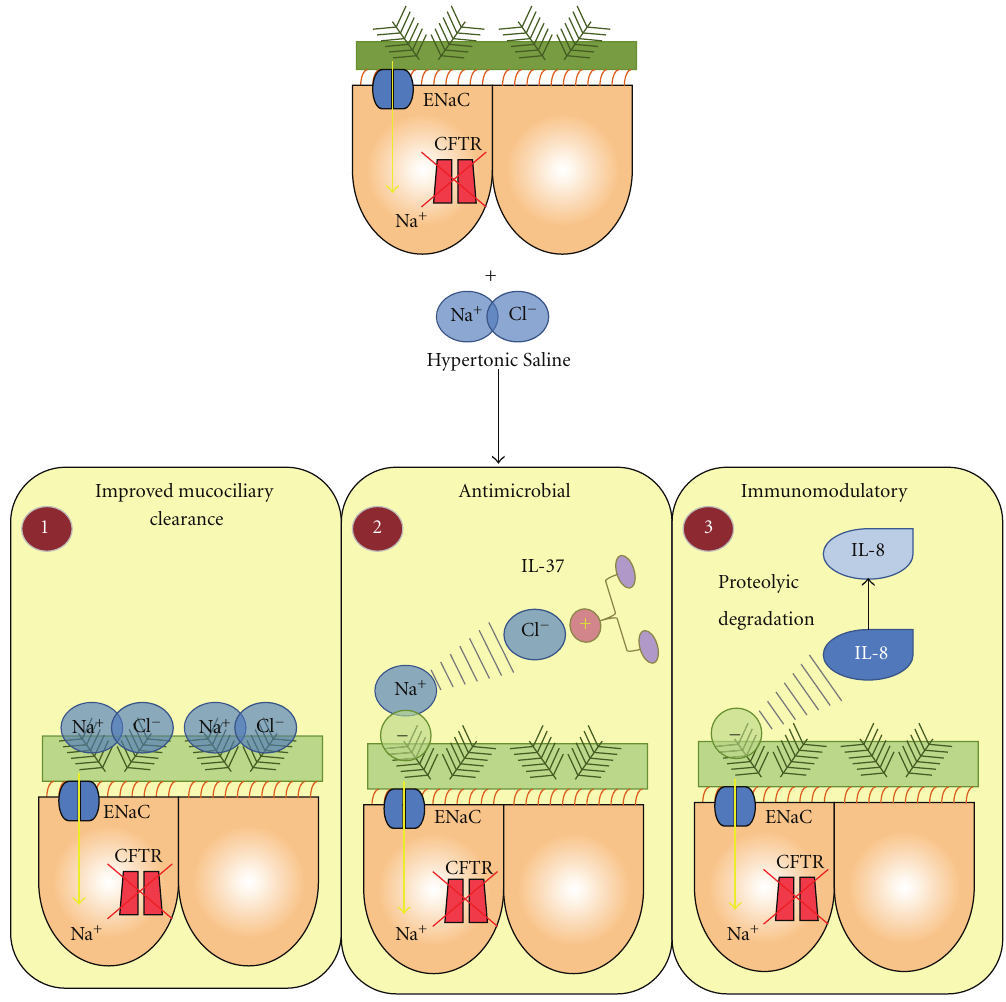
Figure 4: Schematic representation of the antimicrobial, immunomodulatory and mucolytic properties of HTS. (1) HTS draws water into the dehydated CF periciliary layer and improves mucus rheology and enhances mucociliary clearance. (2) LL-37, an antimicrobial protein that is inhibited by GAGs, is released by HTS via disruption of the electrostatic interaction between LL-37 and GAGs. (3) HTS liberates IL-8 from anionic matrices (GAGs) rendering the chemokine susceptible to proteolytic degradation by neutrophil elastase, thereby decreasing